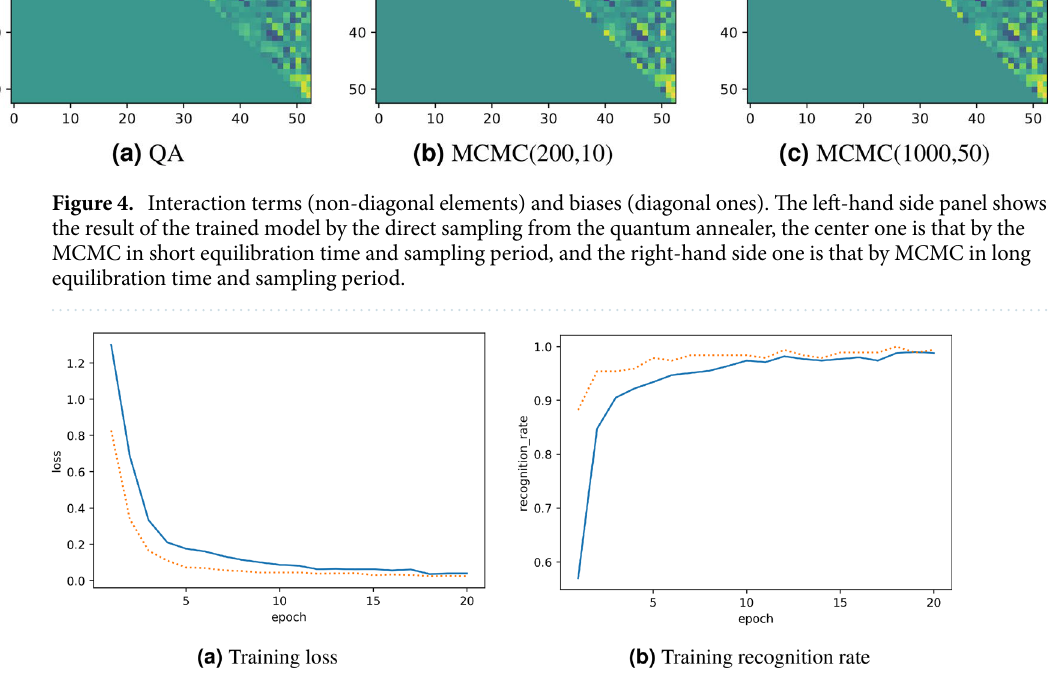
Figure 5. Results of discriminator training. The solid and dotted lines correspond to the results of training and validation,